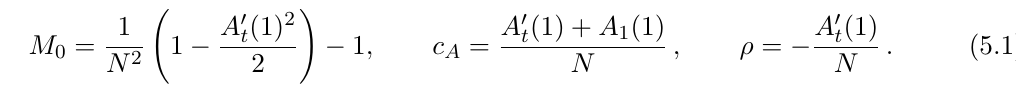
JHEP05(2021)189